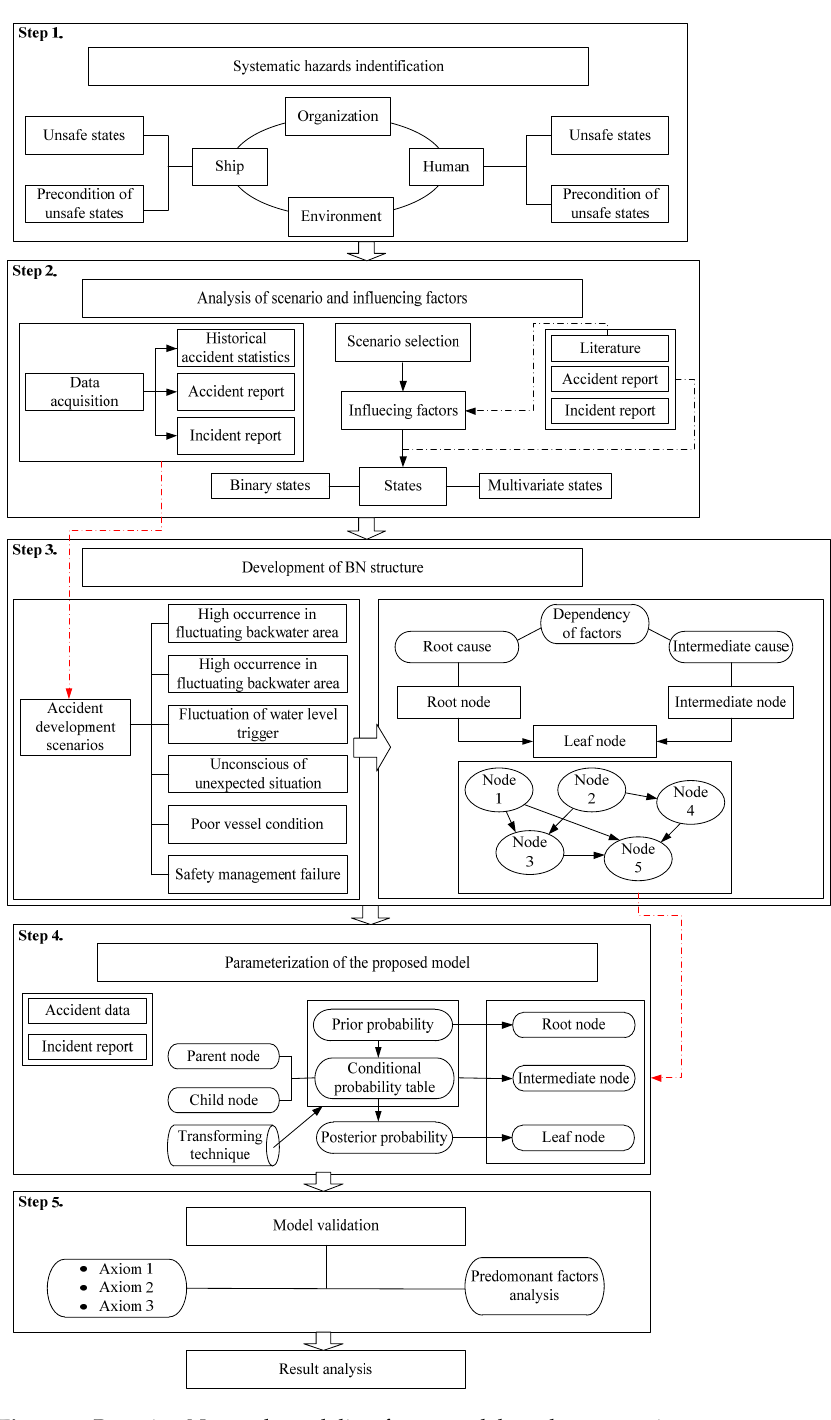
Figure 2. Bayesian Network modeling framework based on scenario.